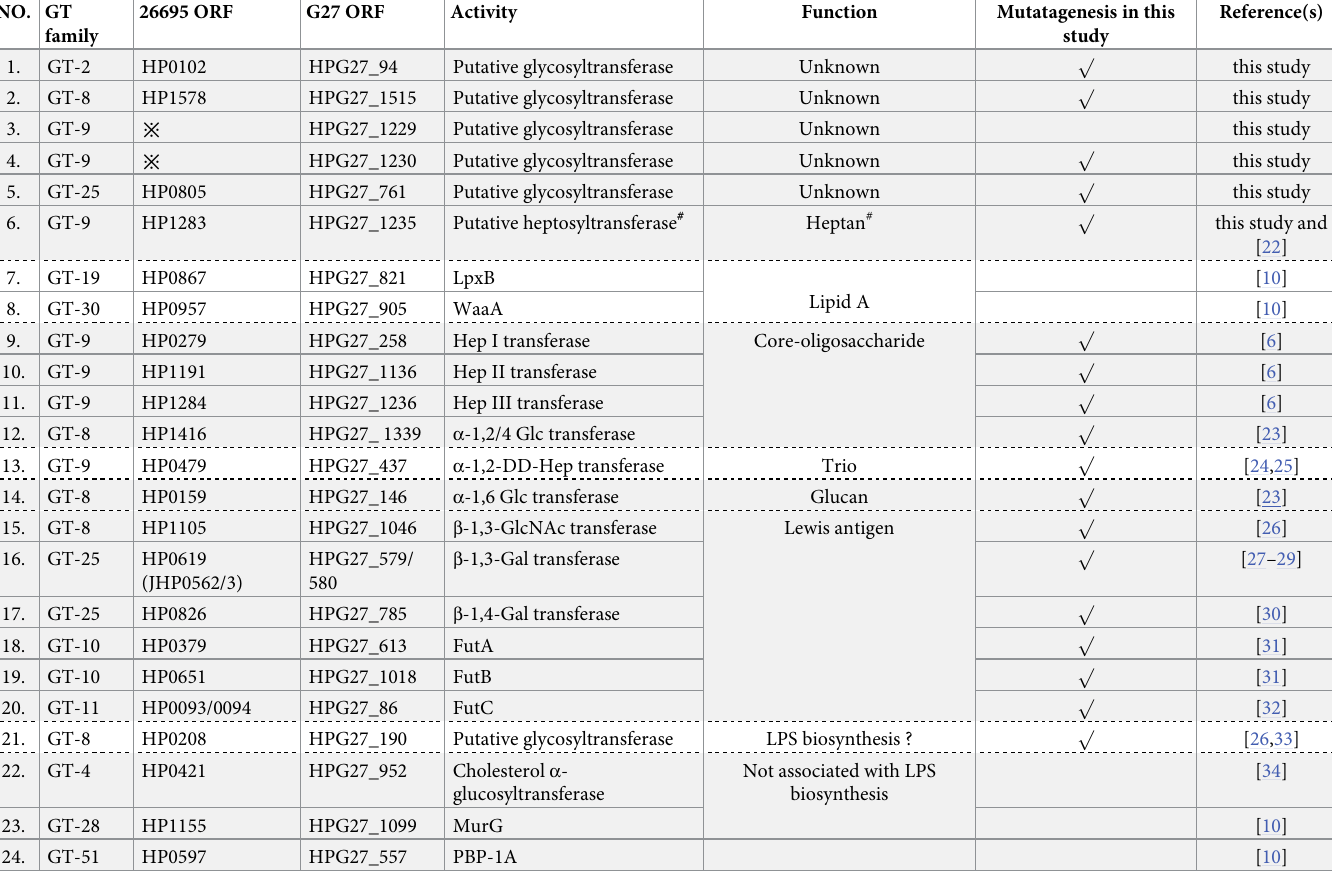
and WaaL (HP1039) involved in the O-antigen initiation, translocation and ligation, respec- tively, were also included for mutagenesis to allow for better comparison of LPS phenotypes [36]. Using the Xer-cise gene deletion technique developed by our group [37], all the selected LPS genes except the essential Hep I transferase gene HP0279 [38], were successfully deleted in the single genetic background G27. Subsequently, LPS samples isolated from G27 wild-type and the isogenic mutants were resolved on SDS-PAGE for comparison of LPS length by silver staining and of Lewis antigen expression by Western blot. Apparent LPS truncation was observed in 11 mutants with LPS length increasing in the following order G27 Δ HP1191 <